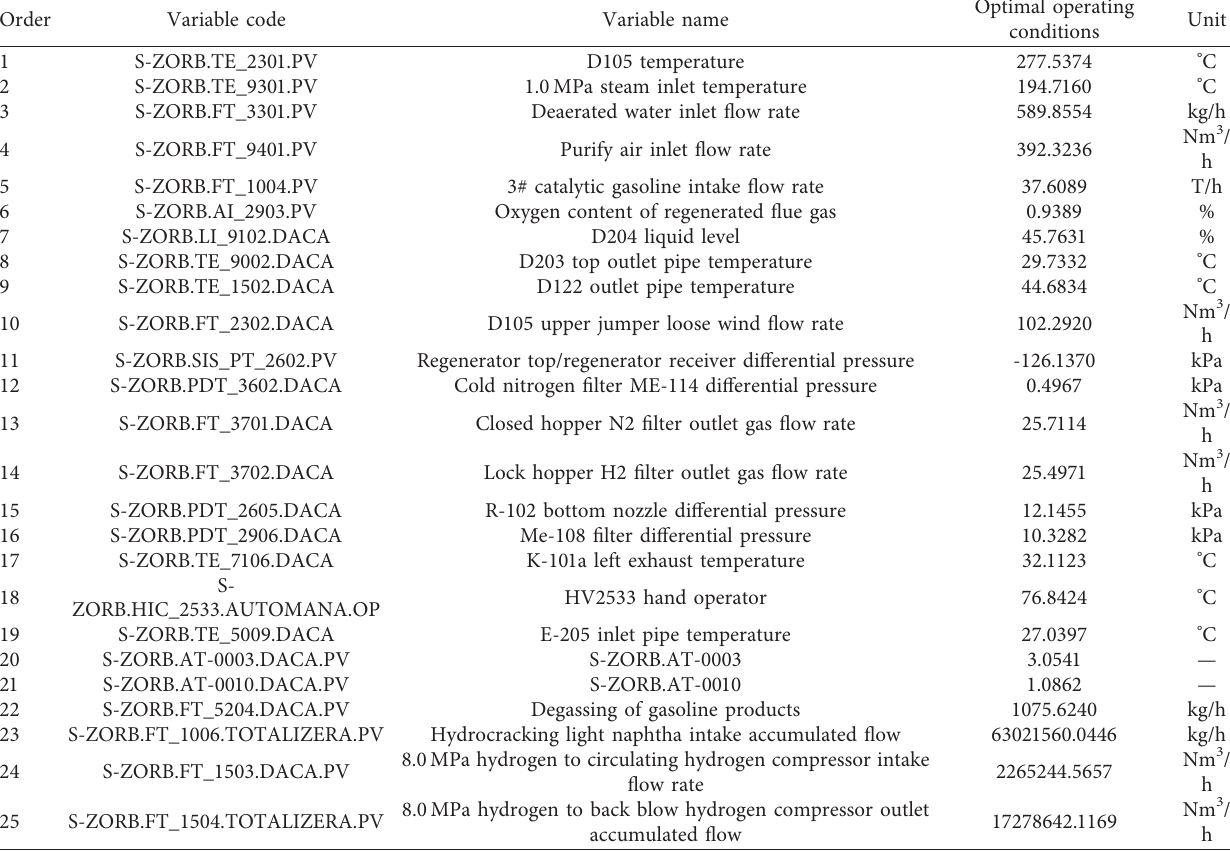
Table 3: The optimal operating conditions of the main operating variables.